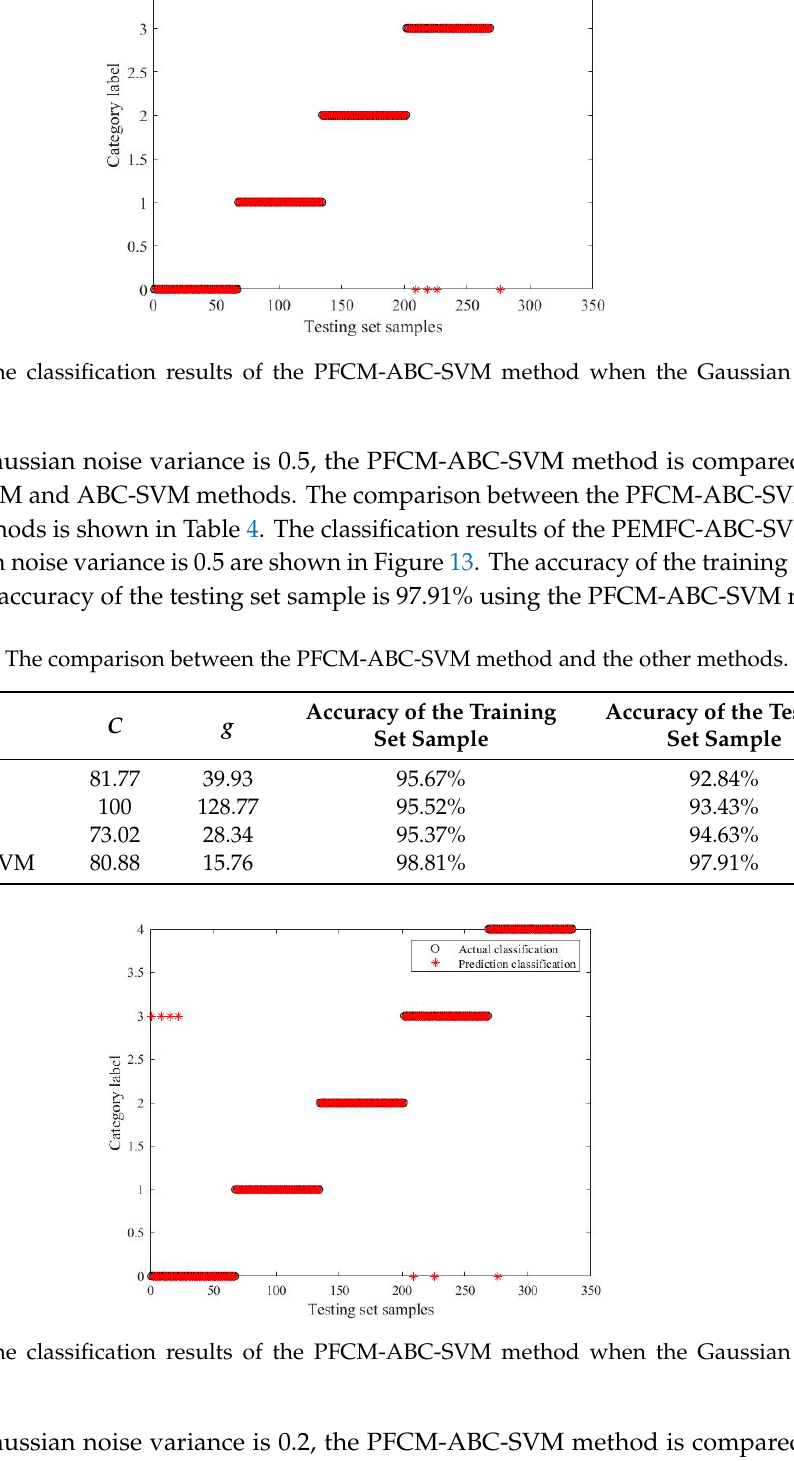
Table 5. The comparison between the PFCM-ABC-SVM method and the other methods.